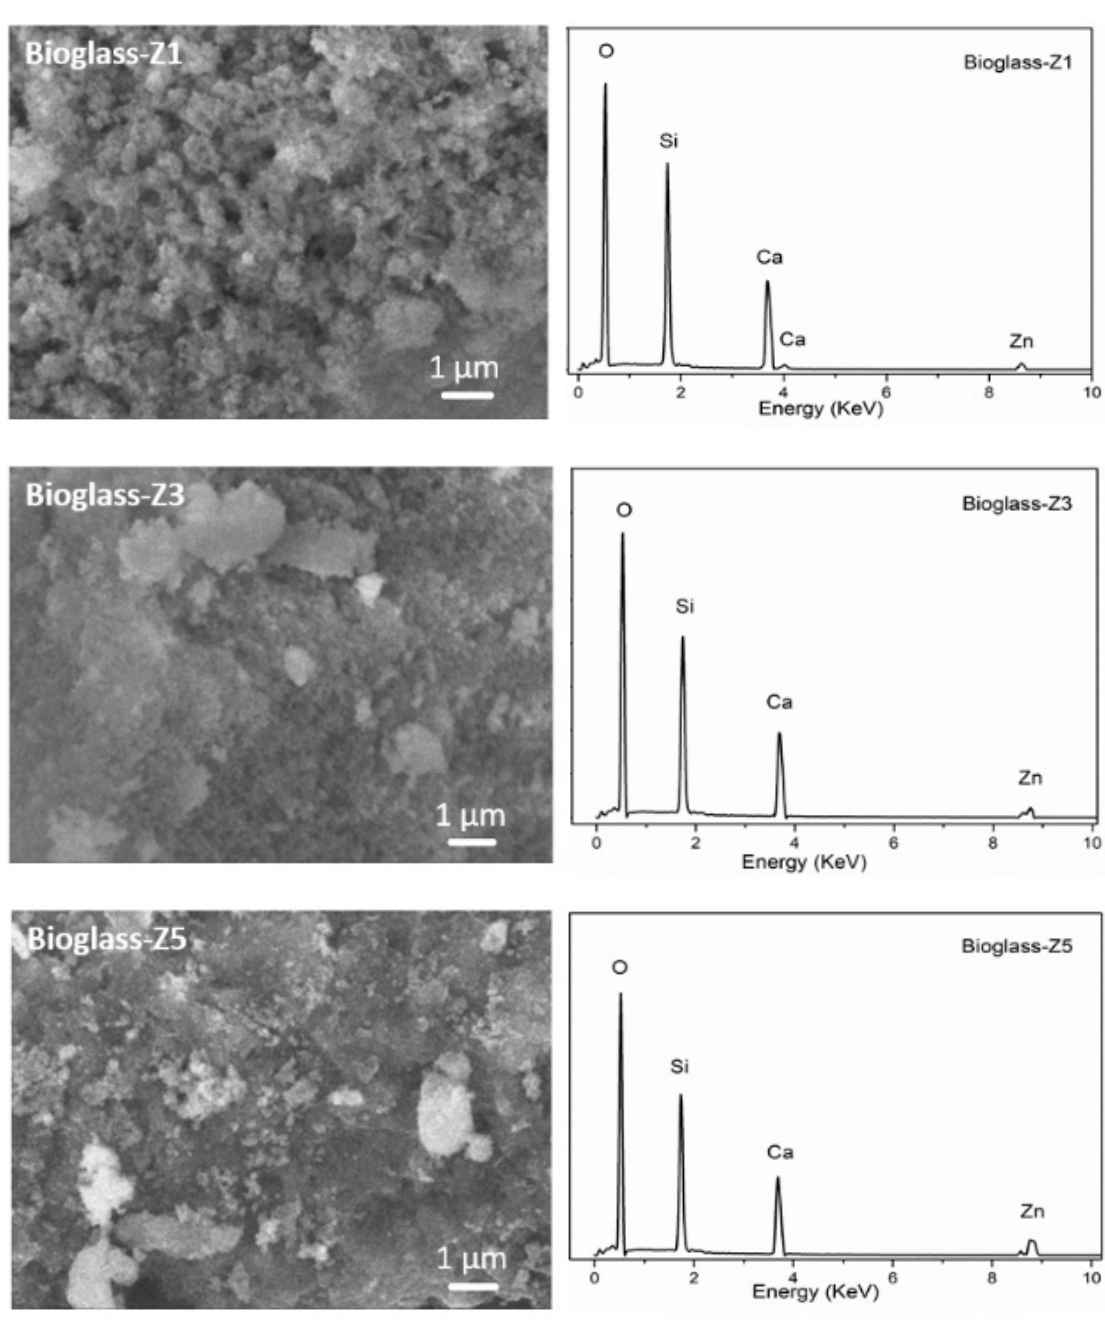
Figure 3. SEM–EDX analyses of bioactive glasses 70SiO2-(30-x)CaO-xZnO (mol.%, x = 1, 3,